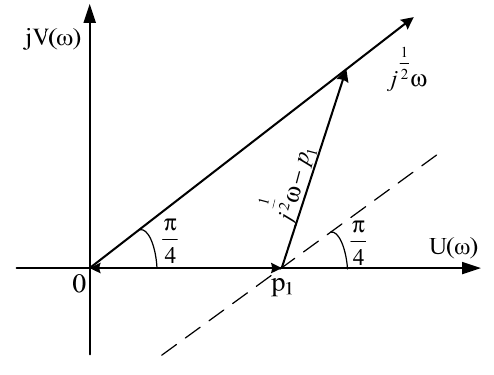
(cid:16) (cid:17) j 1 2 ω − p 1 Figure 2. Vector displacement for the first root in this case when ω (cid:101) ( 0, ∞ ) . (cid:3117) Figure 2. Vector (cid:4672)𝑗 (cid:3118) 𝜔 − 𝑝 (cid:2869) (cid:4673) displacement for the first root in this case when 𝜔 𝜖 (0, ∞) .